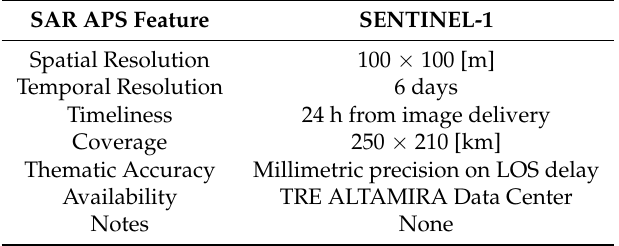
Table A1. The characteristics of the APS